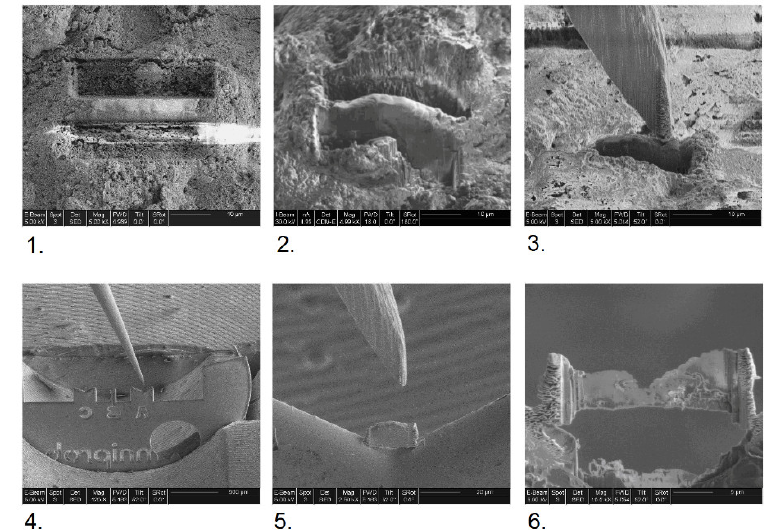
Figure 21. Focused Ion Beam sample preparation steps 1–6. Steps 1 and 2 are from the milled trenches on the surface of the catalyst. Steps 3–5 are from the lift-out and mounting procedure. Step 6 is the final thinned sample.